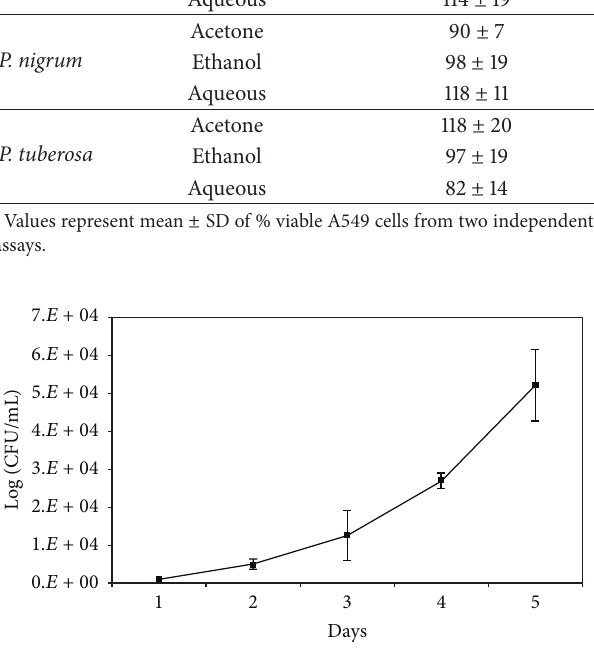
Figure 1: Intracellular growth of H37Rv over a period of 10 days in A549 based epithelial cell model. The results are represented as mean ± SD of three experiments. An increase of ∼1.5 log is observed in growth.